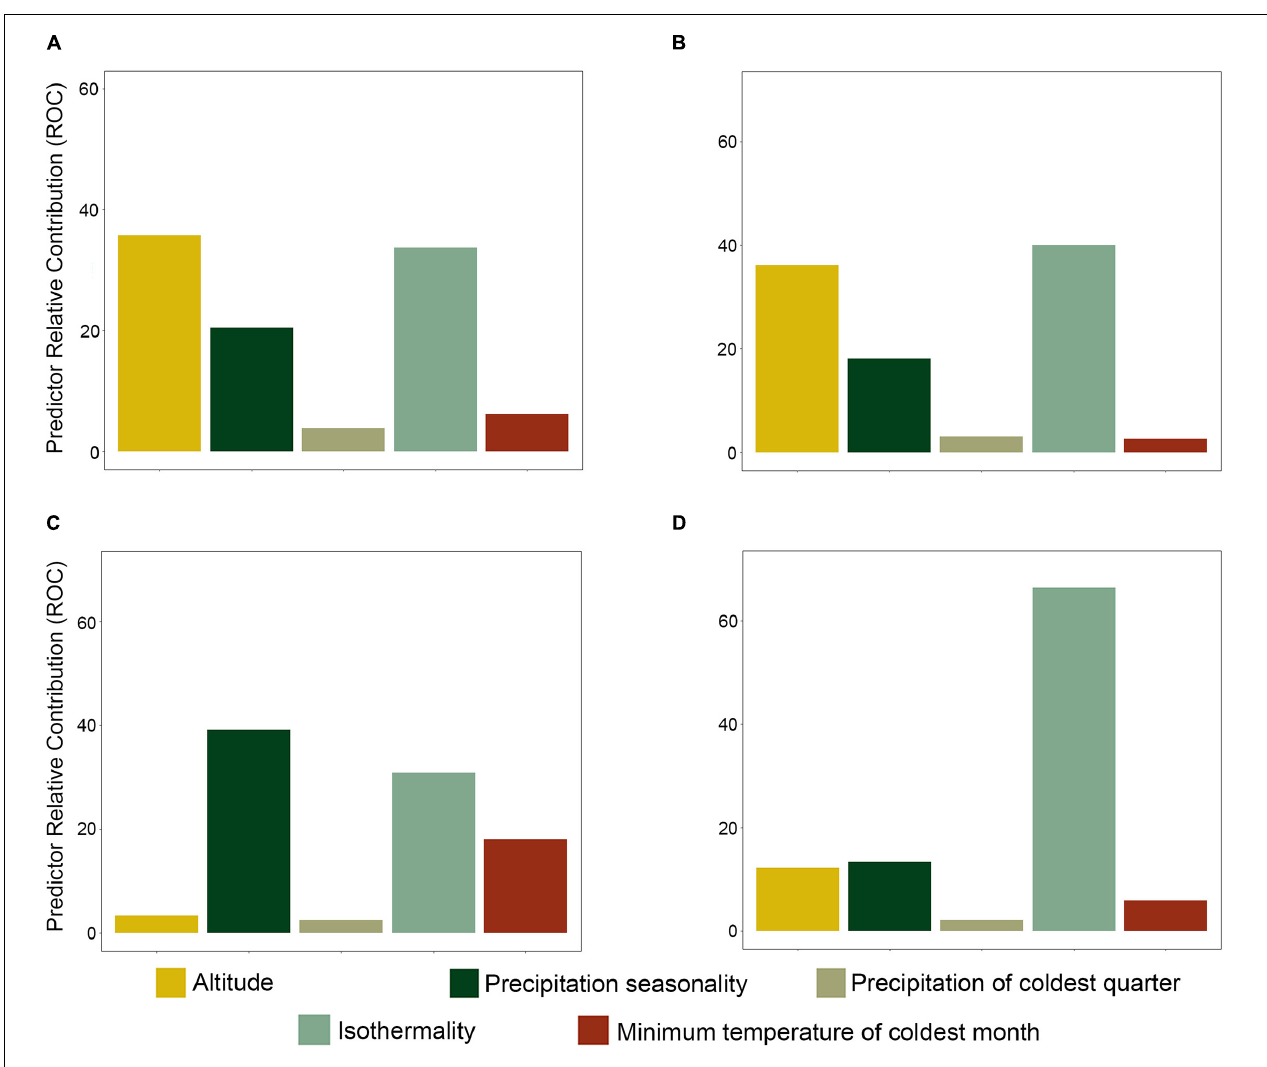
FIGURE 3 | Relative importance of predictors (environmental variables) of diversity. (A) Species richness, (B) phylogenetic diversity, (C) phylogenetic endemism, and (D) residuals of the phylogenetic diversity/species richness regression.